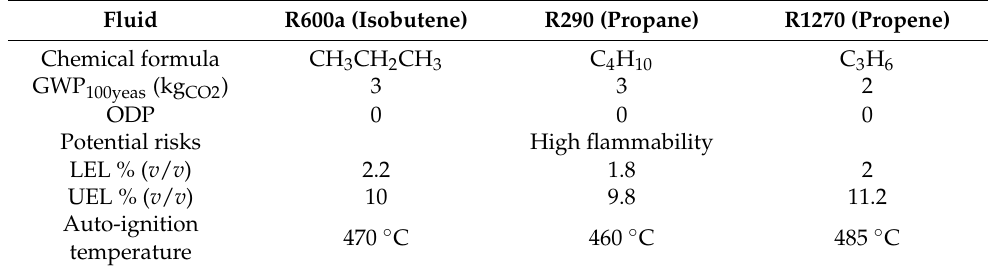
Table 6. Characteristics of isobutene, propane and propene.